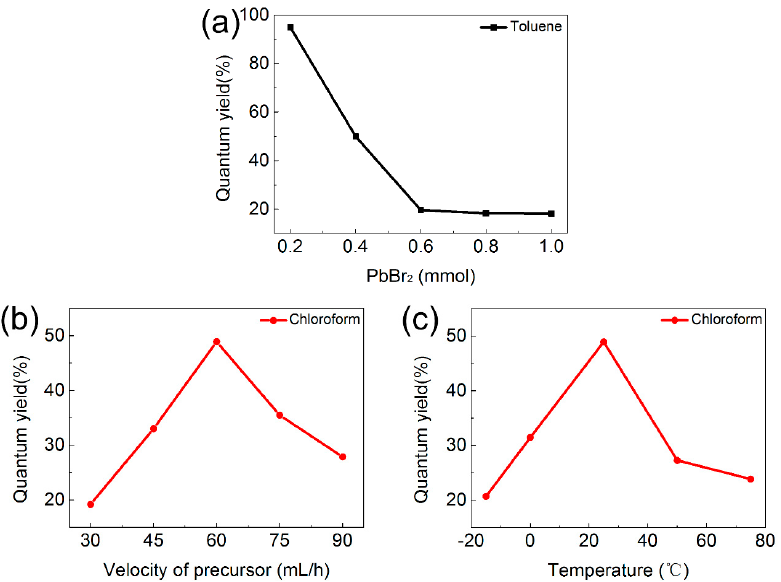
Figure A9. QY image of QDs-M by ( a ) changing dosage of PbBr 2 , ( b ) changing precursor flow velocity with toluene as nonpolar solvent, ( c ) changing precursor flow velocity with chloroform as nonpolar solvent.